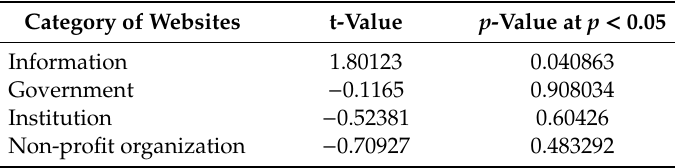
Table 6. t-values for all categories of websites at p <